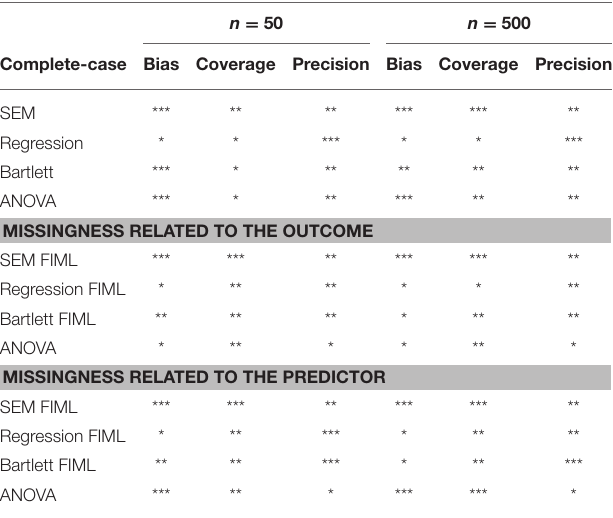
actor effects (partner effects, respectively) equals zero. The data- TABLE 4 | Comparison of the methods: SRM as